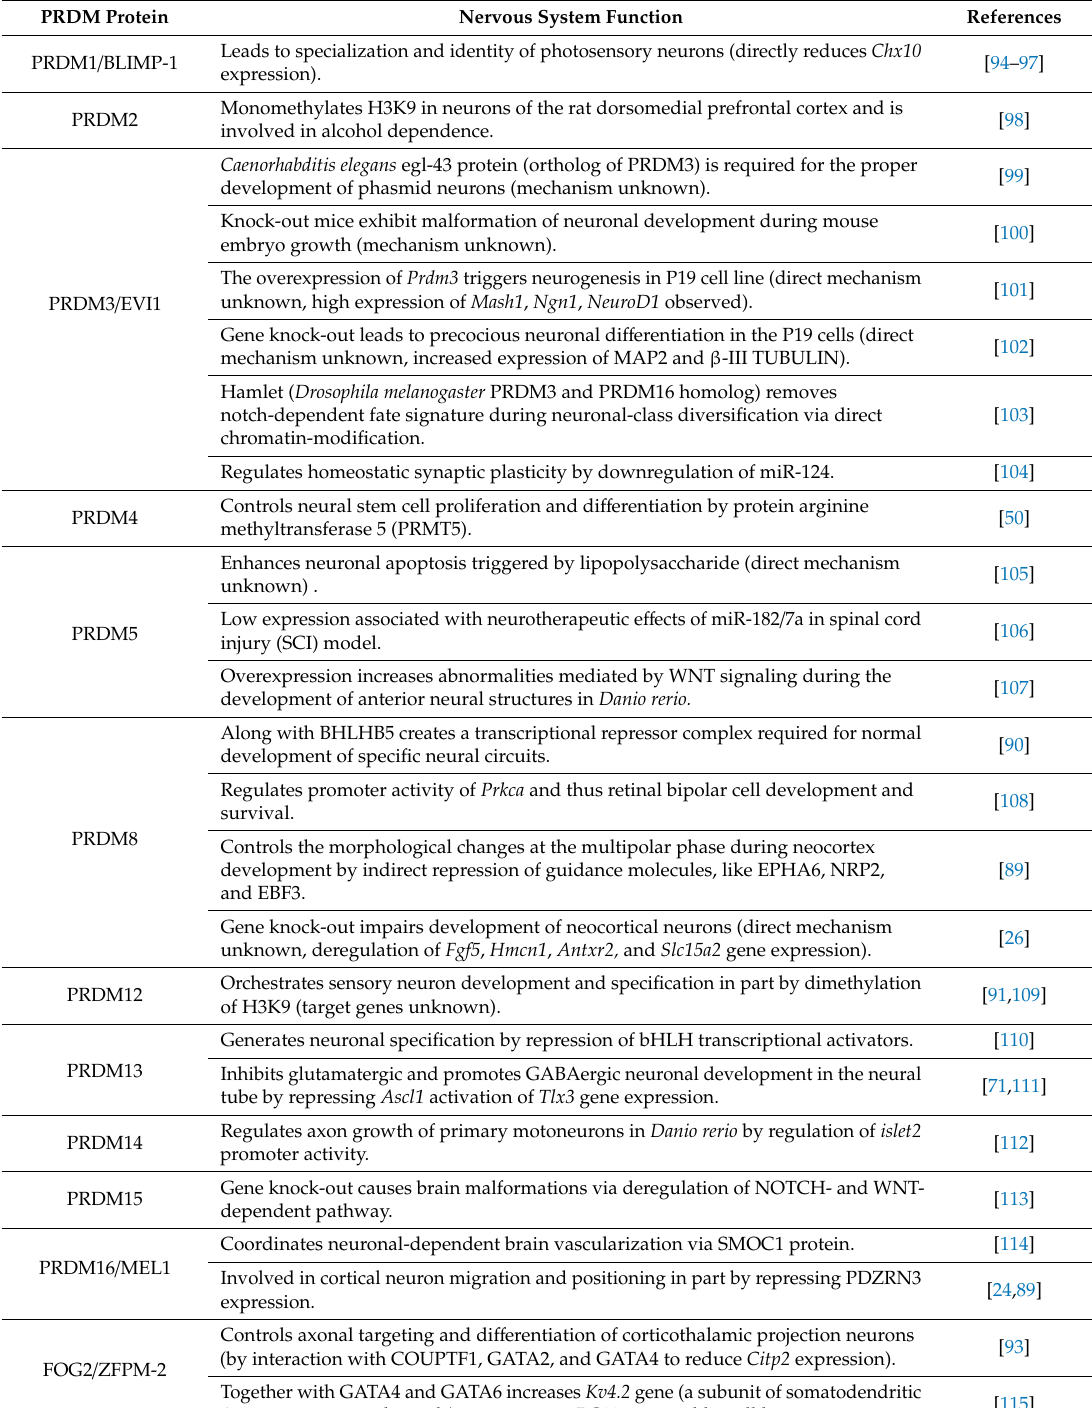
Table 2. The roles of PRDM factors in the neuronal